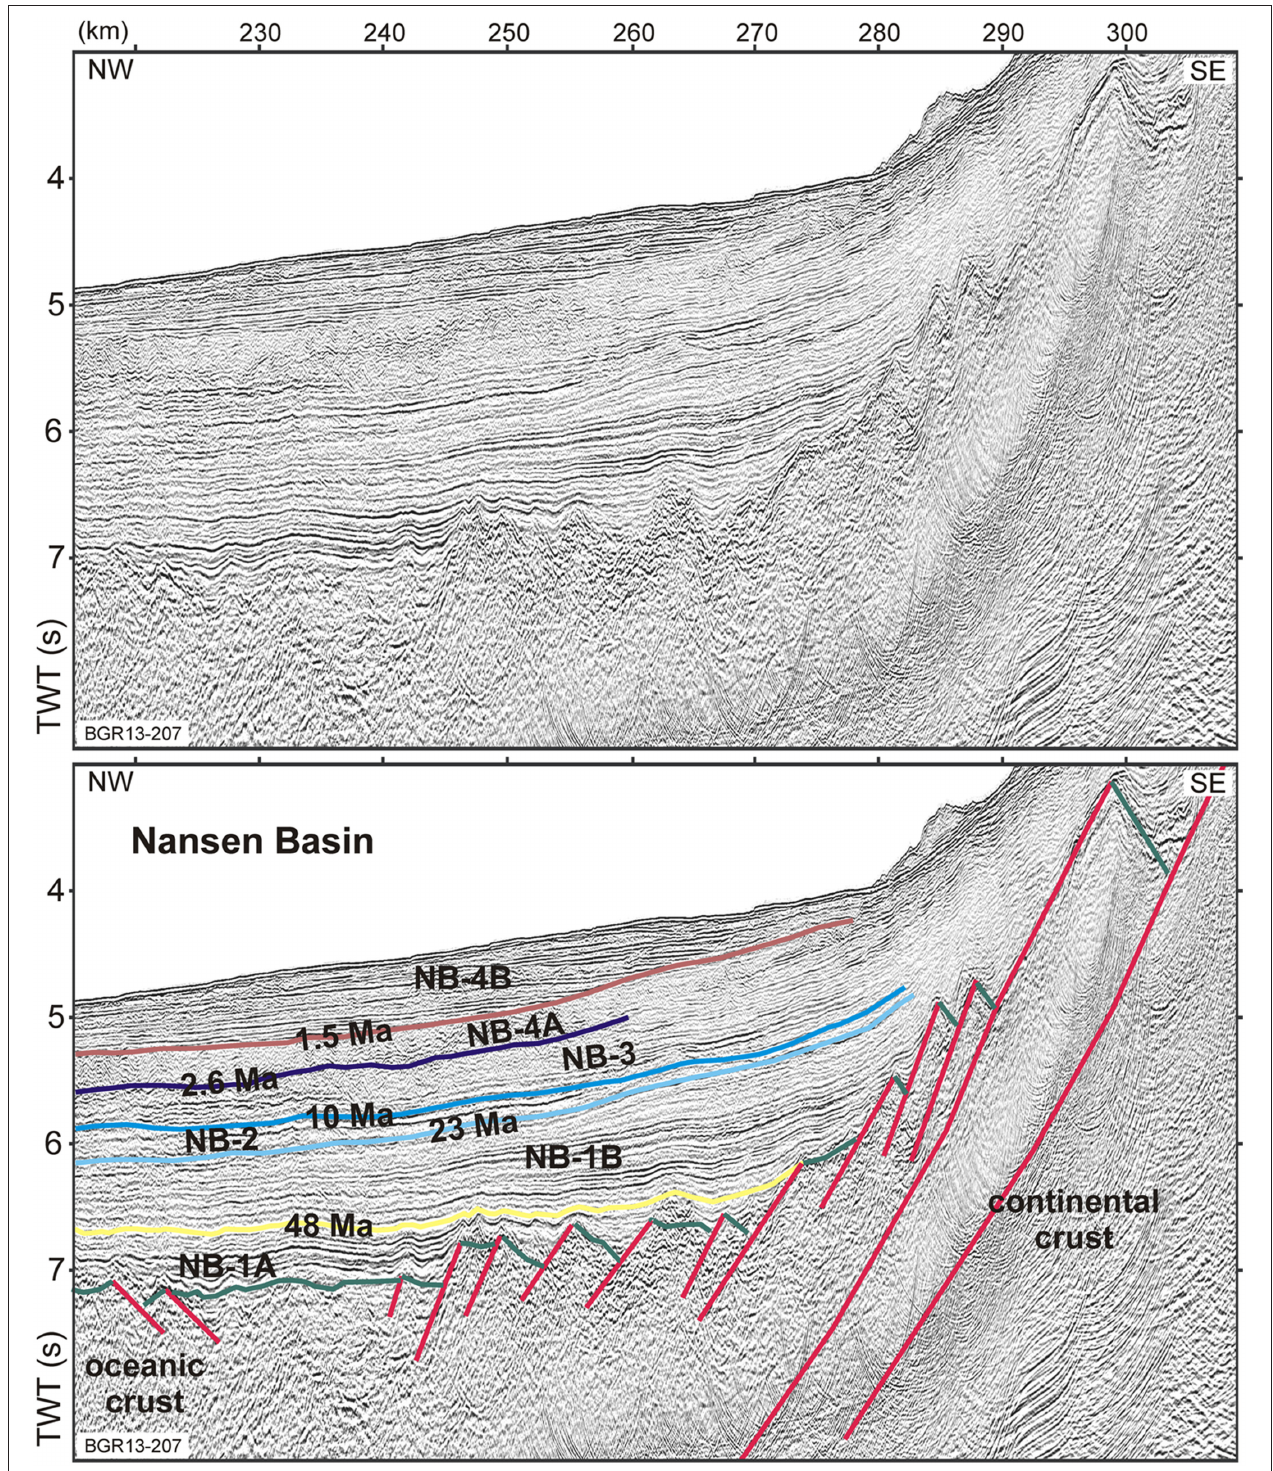
FIGURE 5 | Zoom of the continental margin north of the Barents Shelf shown in Figure 3, indicating a very narrow transition from oceanic to continental crust. Oldest sedimentary unit is NB-1A overlying the oceanic crust and infilling small basins formed by disrupted basement blocks (km 245–275).